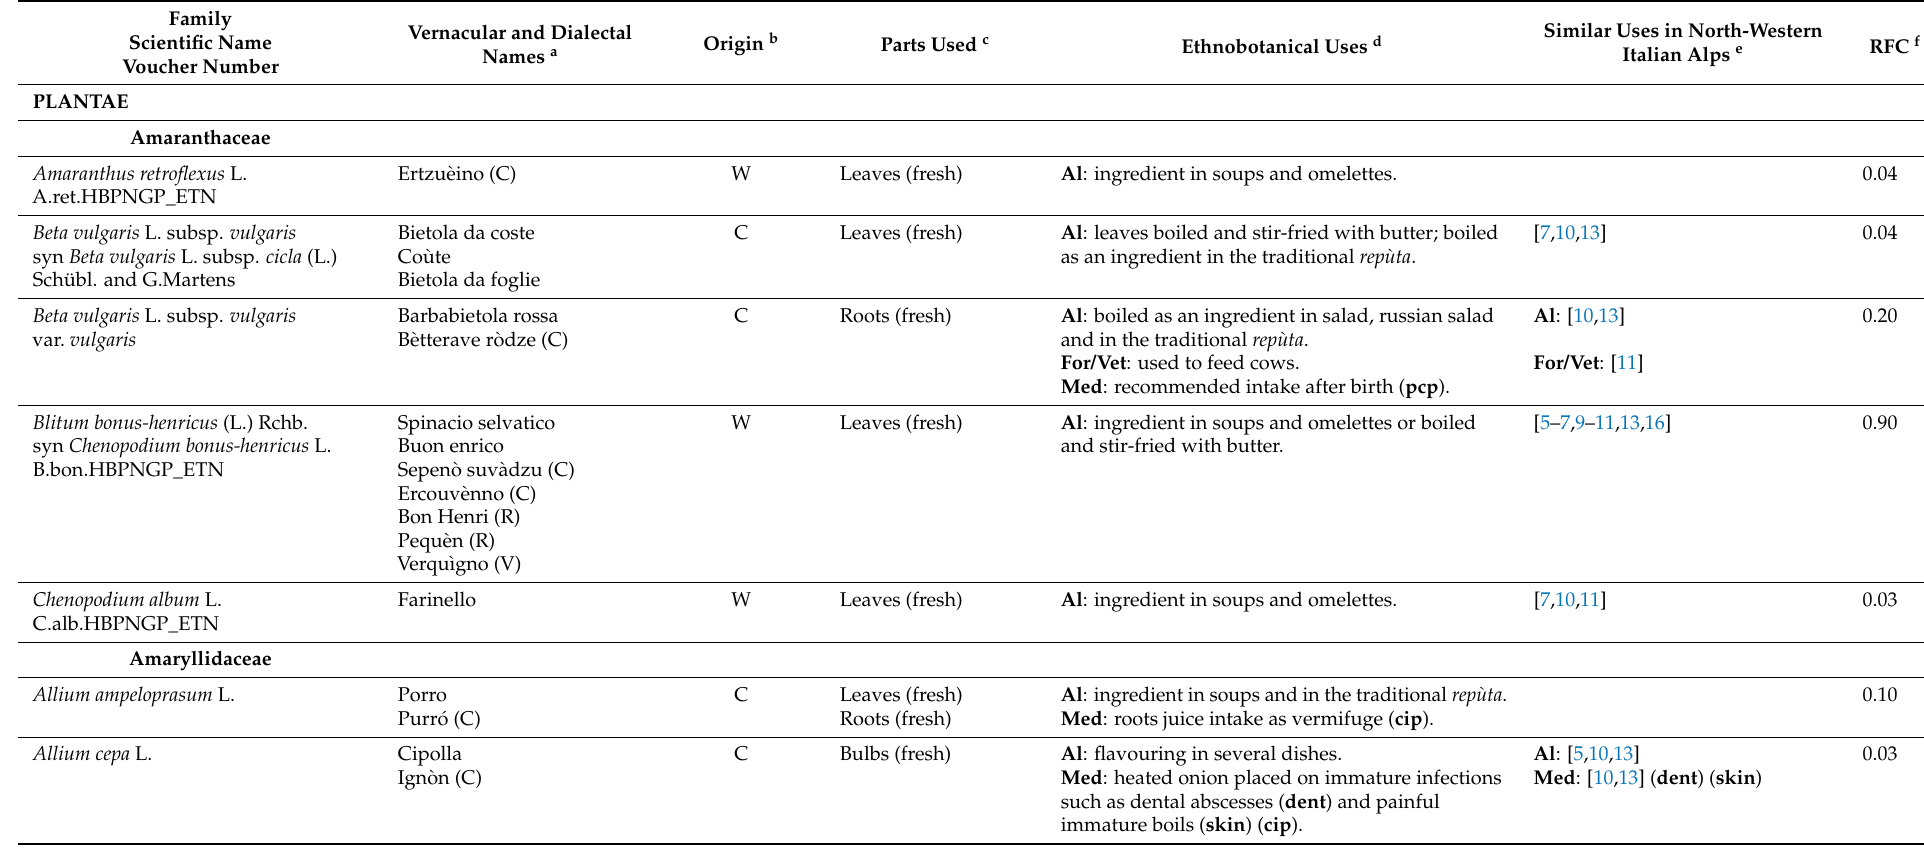
Table 2. Traditional uses of plants, fungi, lichens and others in the Gran Paradiso National Park (Aosta Valley).